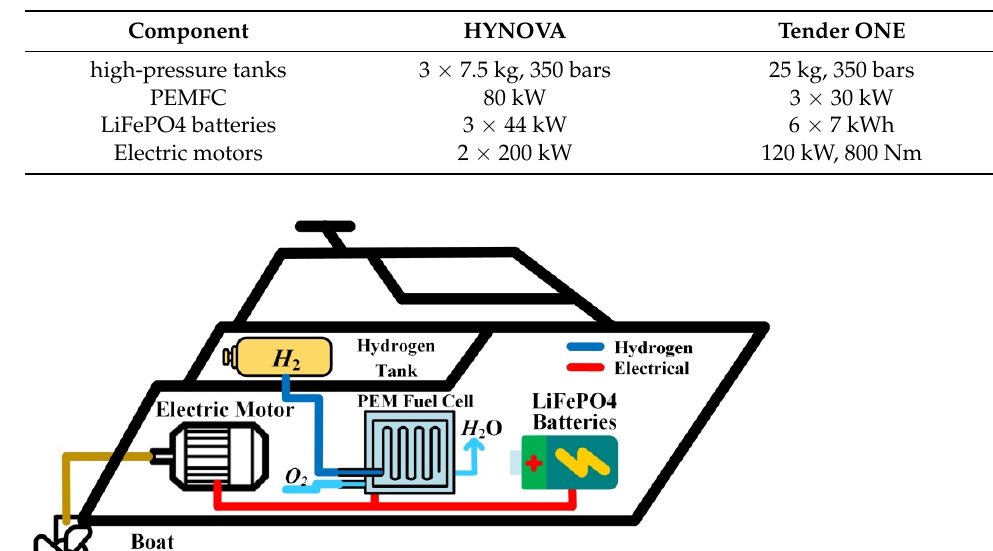
Table 3. Main specifications of the hydrogen-powered yacht and vessel [63,64].